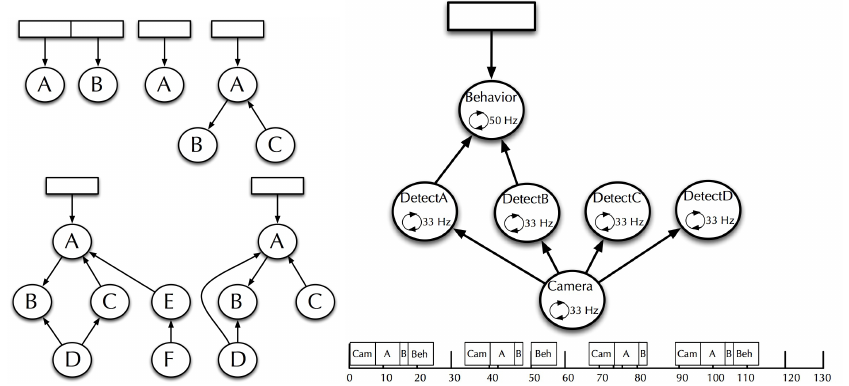
Figure 3. Different possible topologies in BICA ( left ). An example of a perceptive behavior implementation using BICA ( right